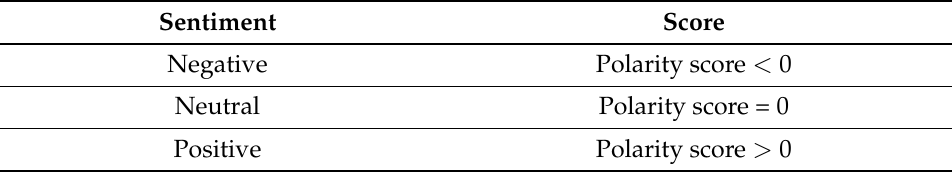
Algorithm 1 TextBlob algorithm for sentiment